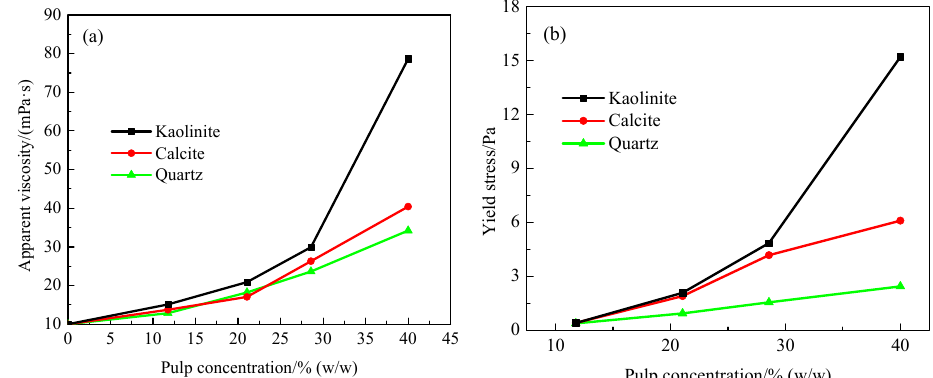
Figure 5. Effect of pulp concentration on ( a ) apparent viscosity and ( b ) yield stress of mixed ore pulp (octadecylamine concentration: 150 mg/L). (octadecylamine concentration: 150